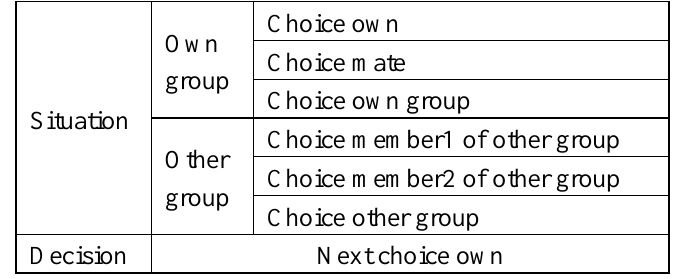
Table 2 . Example of an instance: the Situation part holds choices from the previous round for the own group and the opposing group; the Decision part holds the choice for the current